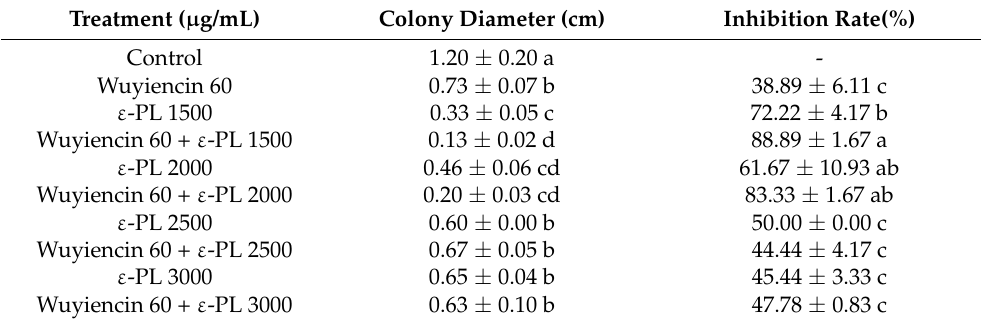
Figure 5. In vitro protective capability ε -PL combined with wuyiencin to control Botrytis cinerea on tomato leaves. Table 4. Control efficiencies of wuyiencin and ε -PL on tomato grey mold in the